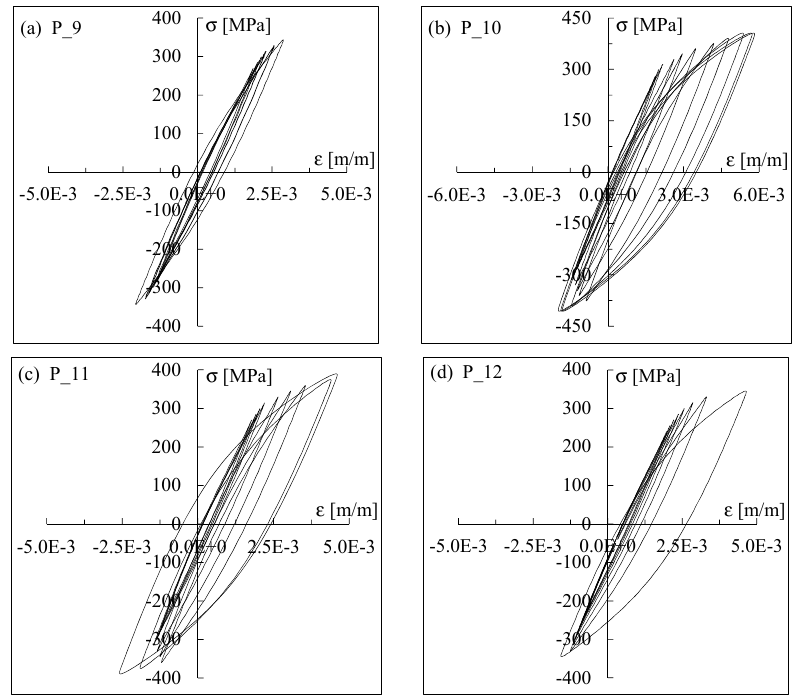
Figure 16. Stabilized hysteresis loops measured during the step-load fatigue tests for ( a ) P_9, ( b ) P_10, ( c ) P_11 and ( d ) P_12 specimens.